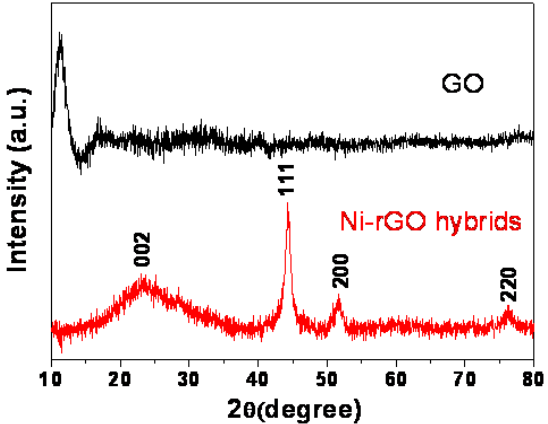
Figure 1. XRD patterns of the as-prepared GO and Ni-rGO